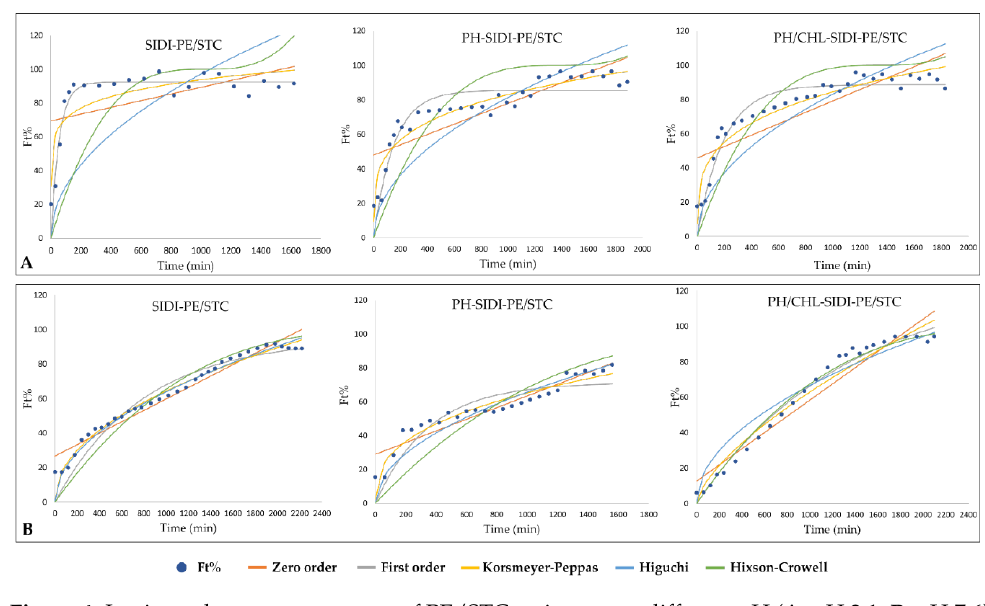
Figure 4. In vitro release assays curves of PE/STC series at two different pH ( A : pH 2.1; B : pH 7.6). The other curves are presented in the Supplementary Materials.